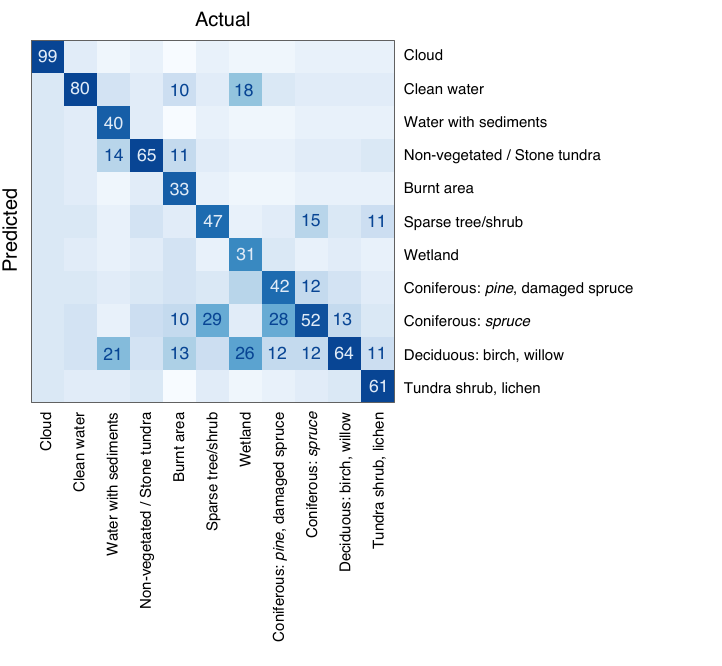
Figure 6. The heat-map plot represents the confusion matrix for the cross-validation of the TensorFlow classifier over the testing set. The shades of blue represent relative fractions of each actual class across all predicted classes (white for zero, blue for 1.0) along with annotations for fractions of 0.05 and above (at least 5% attribution of the actual class to the predicted one). Values off the diagonal represent misclassifications over the testing set.